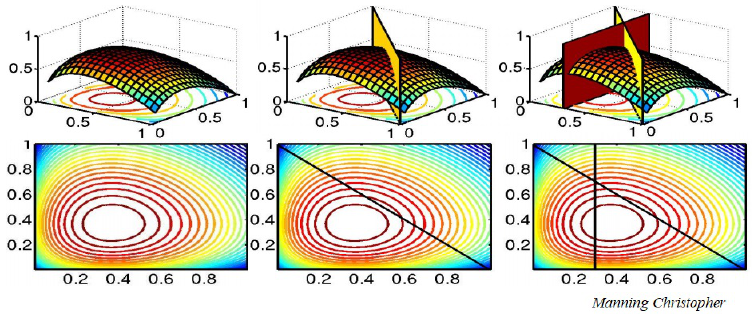
Figure 1. Entropy function subject to